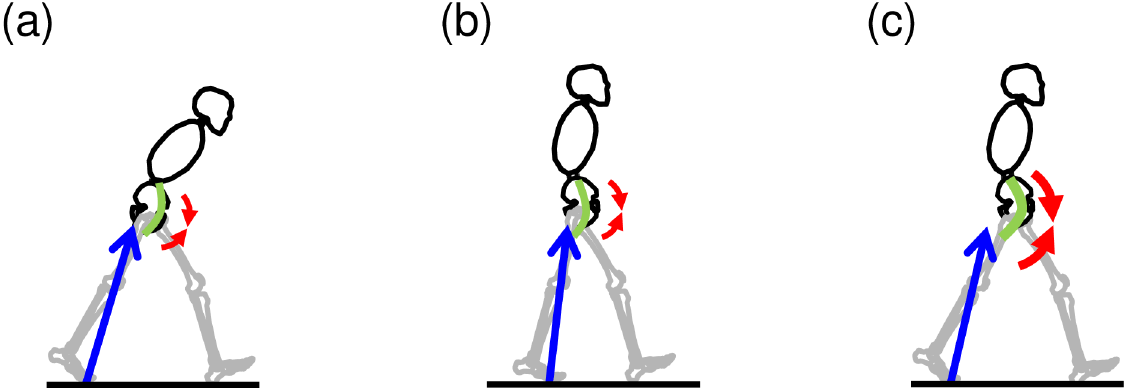
Fig 3. Two strategies used by patients with lumbar spinal stenosis to alleviate symptoms. (a) Trunk flexion posture with an increased step length and hip extension angle. (b) Trunk upright posture with a decreased step length and hip extension angle. (c) Ideal walking posture of healthy people. Red arrows indicate the ground reaction force vector, blue arrow is the hip flexion moment, and green arc is the psoas